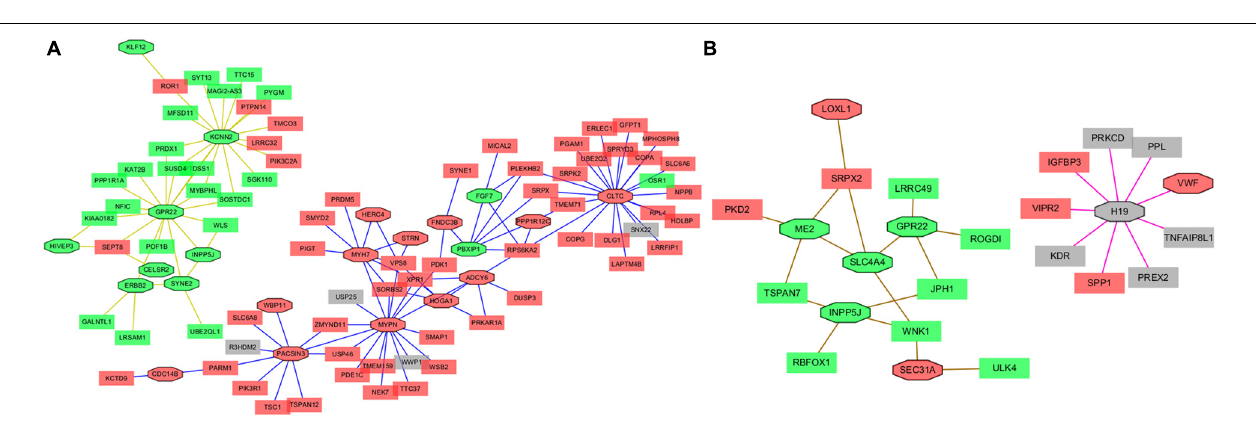
FIGURE 6 | The enrichment pathways from GSEA. (A) The enrichment pathways from GSEA in LAA. (B) The enrichment pathways from GSEA in RAA. LAA, left atrial appendage; RAA, right atrial appendage.